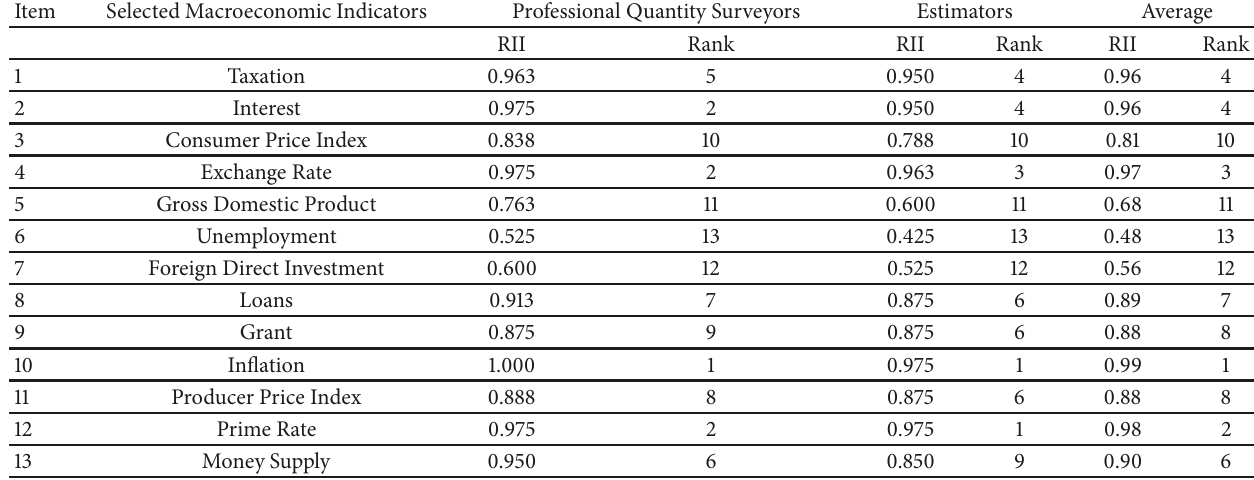
Table 2: Macroeconomic